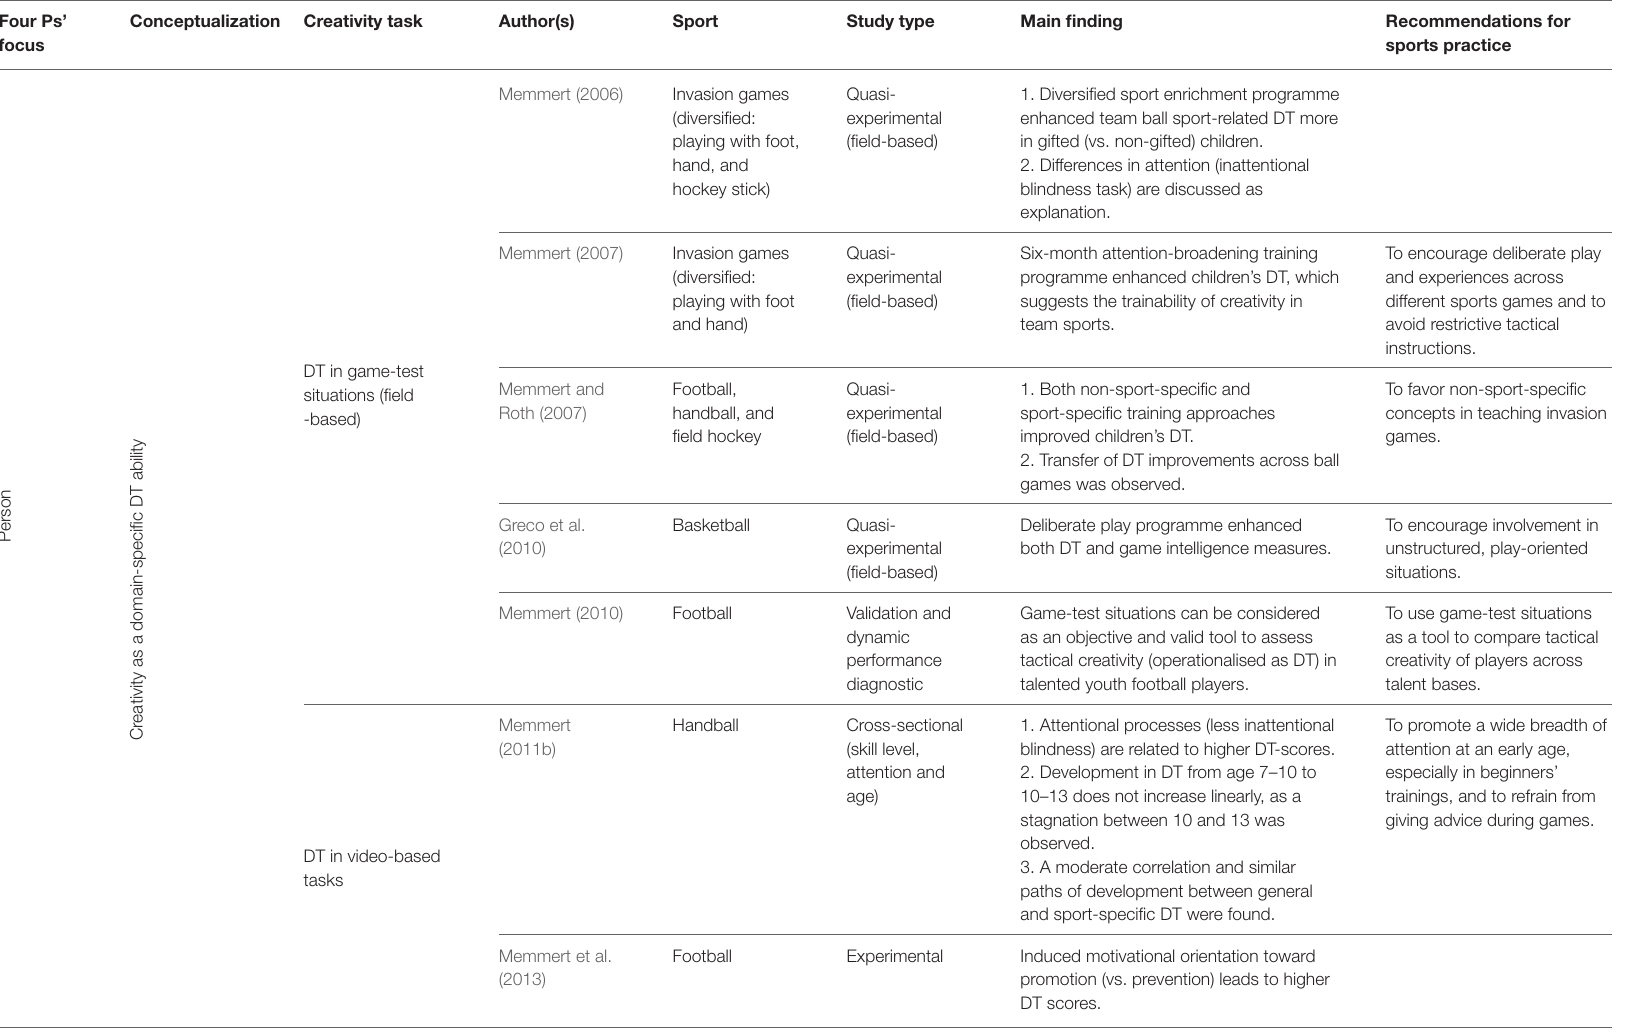
TABLE 1 | Studies on creativity in invasion games classified by their conceptualization of creativity, ordered by four Ps’ focus (person, process, product, press), conceptualization, creativity task, and publication year (alphabetically for studies published in the same